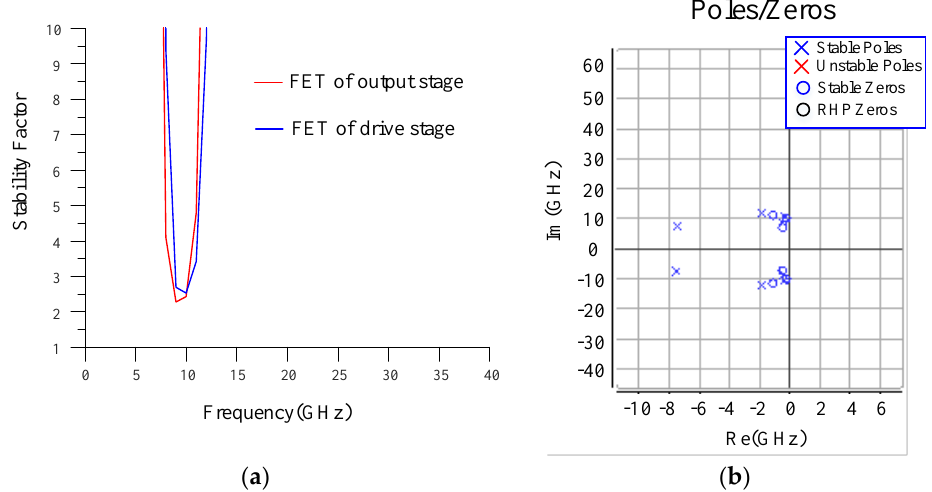
Figure 11. ( a ) Small-signal stability factor of the output stage and driver stage in the proposed PA; ( b ) large-signal stability results for the proposed PA using the pole-zero identification method.